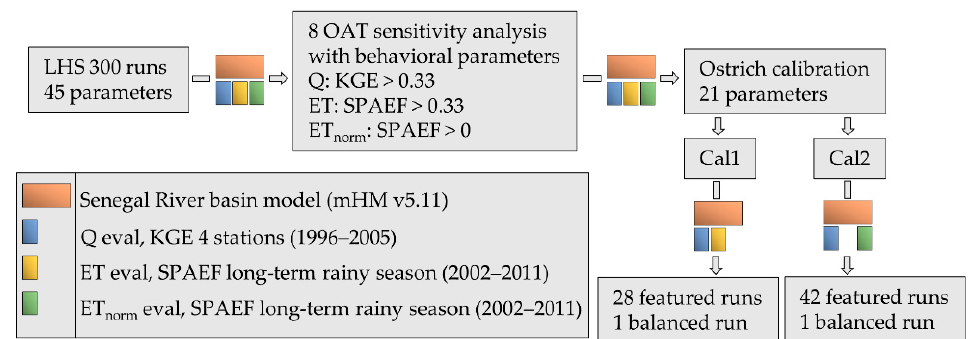
Figure 4. Flow chart of the conducted modelling work and calibration Figure 4 . Flow chart of the conducted modelling work and calibration experiments.